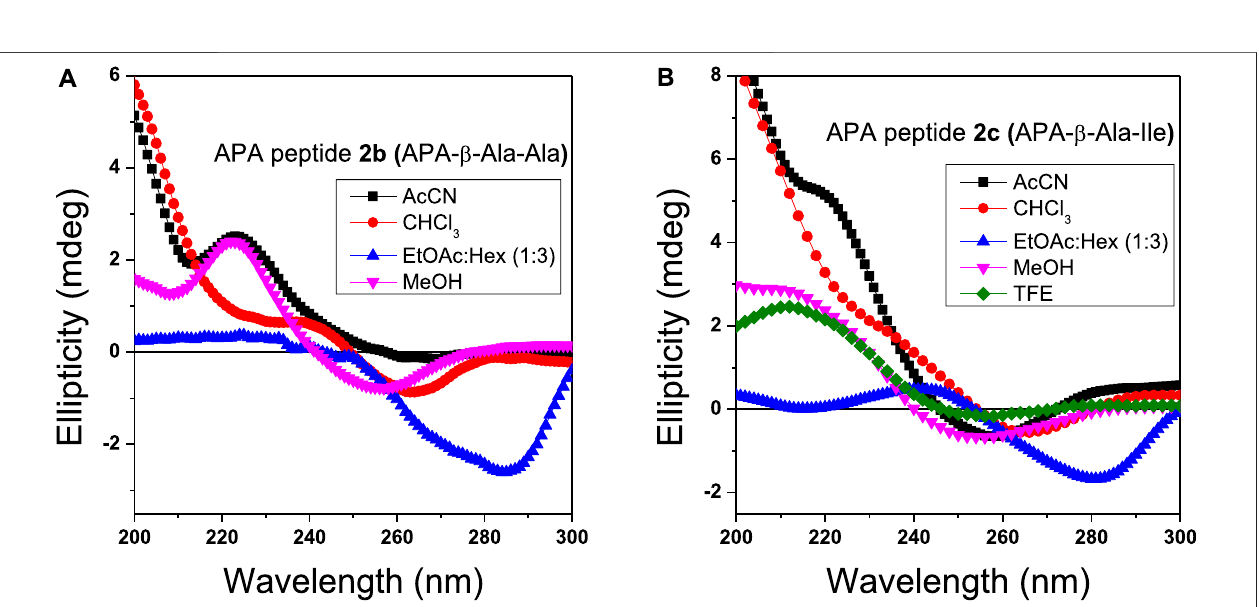
FIGURE4| CD spectra oforganogels 2b (A) and 2c (B) indifferentsolvents (0.1 mM concentration).TheCD spectra inethylacetate and hexane mixture (blue) are signi fi cantly shifted.